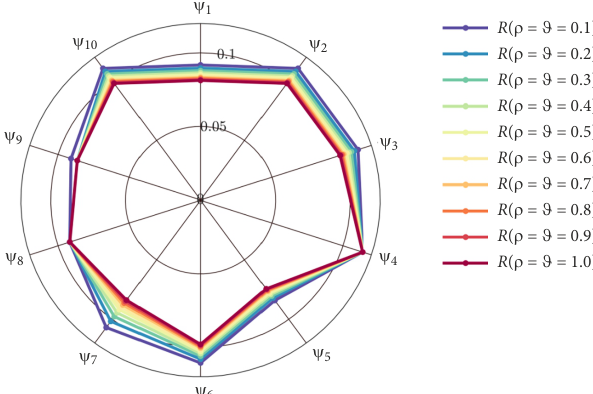
Figure 3. The variation trend of R i with J ∈ [0,1] and r ∈ [0,1]